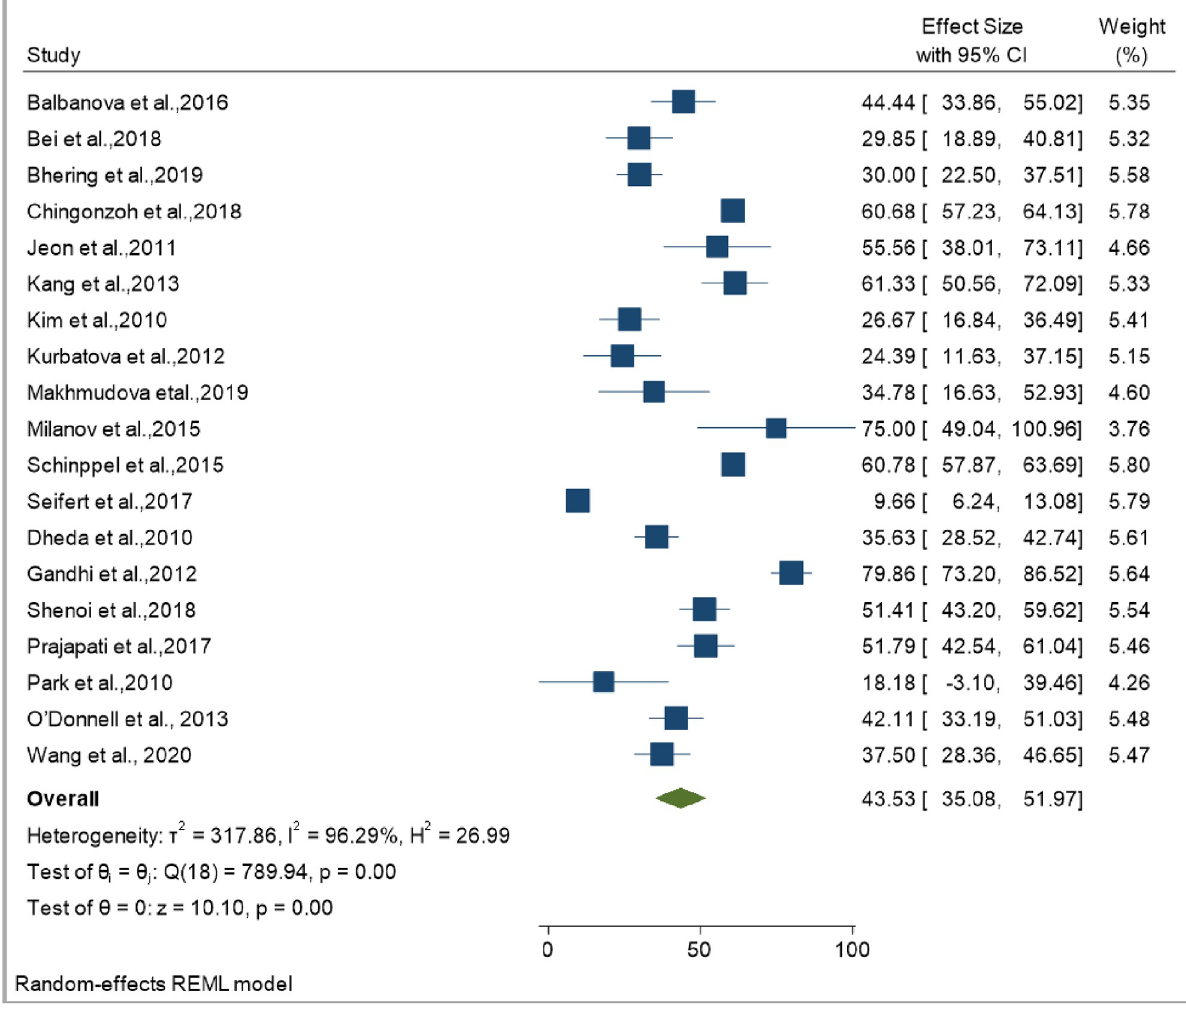
Fig 7. Forest plot for pooled incidence of mortality in patients with extensively drug-resistant tuberculosis.